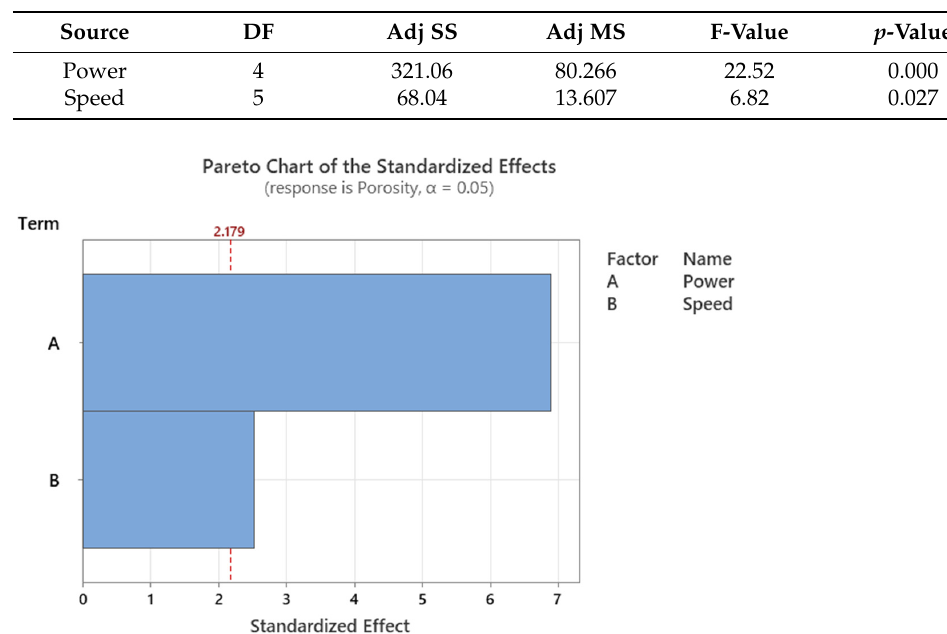
Table 3. Analysis of variance.